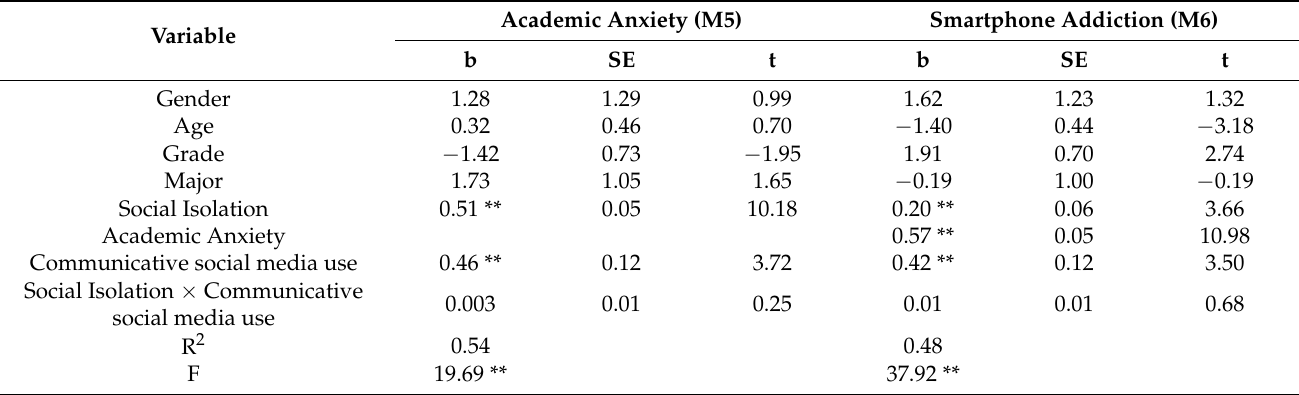
Table 5. Conditional indirect effects analysis.